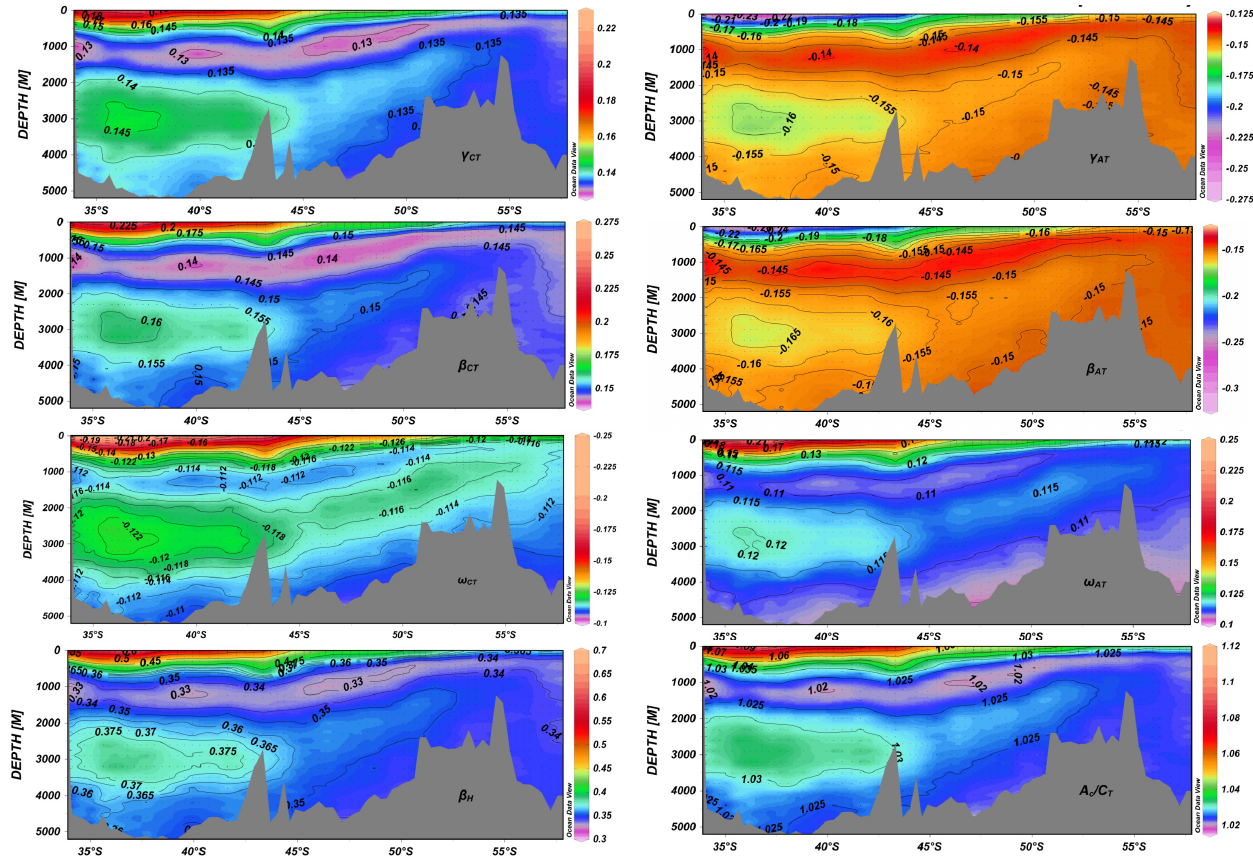
Fig. 5. The vertical distribution of fractional changes in [CO 2 ] ( γ i ) , [H + ] ( β i ) and (cid:127) ( ω i ) (mmolkg − 1 ) over the changes in C T and A T and acid-base buffer capacity, β H , (mmolkg − 1 ) for the whole of the BONUS GoodHope section, together with the ratio of carbonate alkalinity to inorganic carbon A c / C T